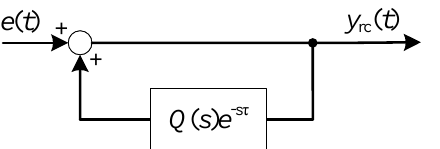
Figure 7. Improved repetitive control